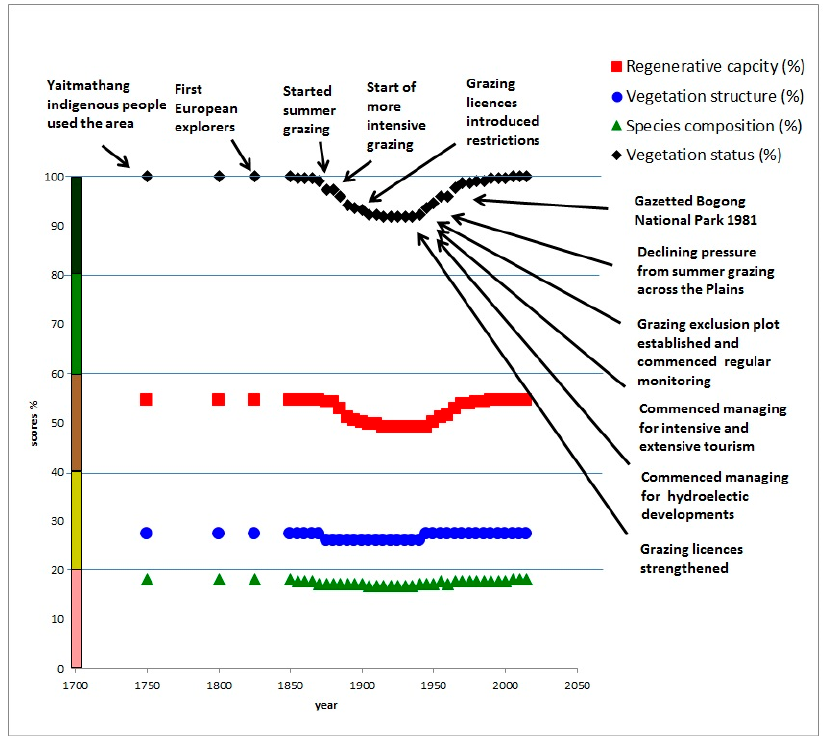
Figure 2. Case Study 1: Rocky Valley, Bogong High Plains, cold wet agro-climate region, Poa tussock grassland.